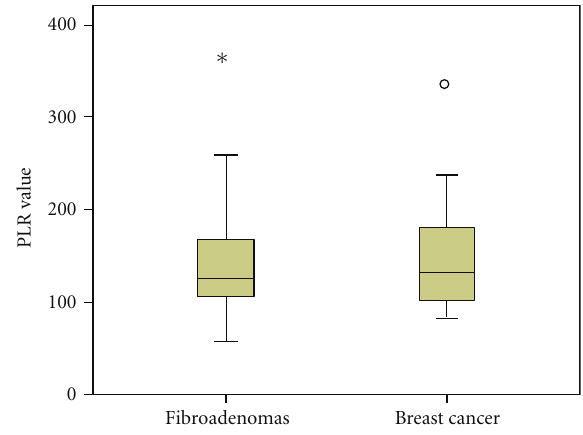
Figure 3: PLR values in groups A versus B and C (fibroadenomas versus breast